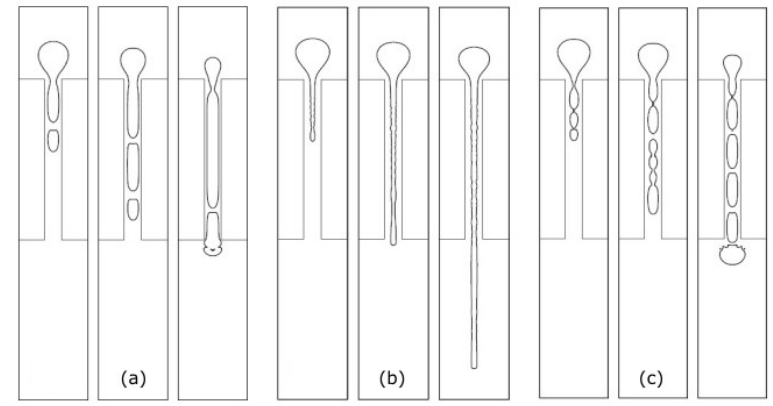
Figure 6. Low ‐ viscosity droplet deformation behaviour in constrictions for Newtonian fluids with Χ (cid:3404) 0.001 : ( a ) Re (cid:3404) 2.13 (cid:3400) 10 (cid:2879)(cid:2871) and S (cid:3404) 2.13 (cid:3400) 10 (cid:2869) ; ( b ) Re (cid:3404) 6.59 (cid:3400) 10 (cid:2879)(cid:2869) and S (cid:3404) 3.97 ; and, ( c ) 0.001: ( a ) Re = 2.13 × 10 − 3 and S = 2.13 × 10 1 ; ( b ) Re = 6.59 × 10 − 1 and S = 3.97; and, ( c ) Re = 6.76 × 10 −